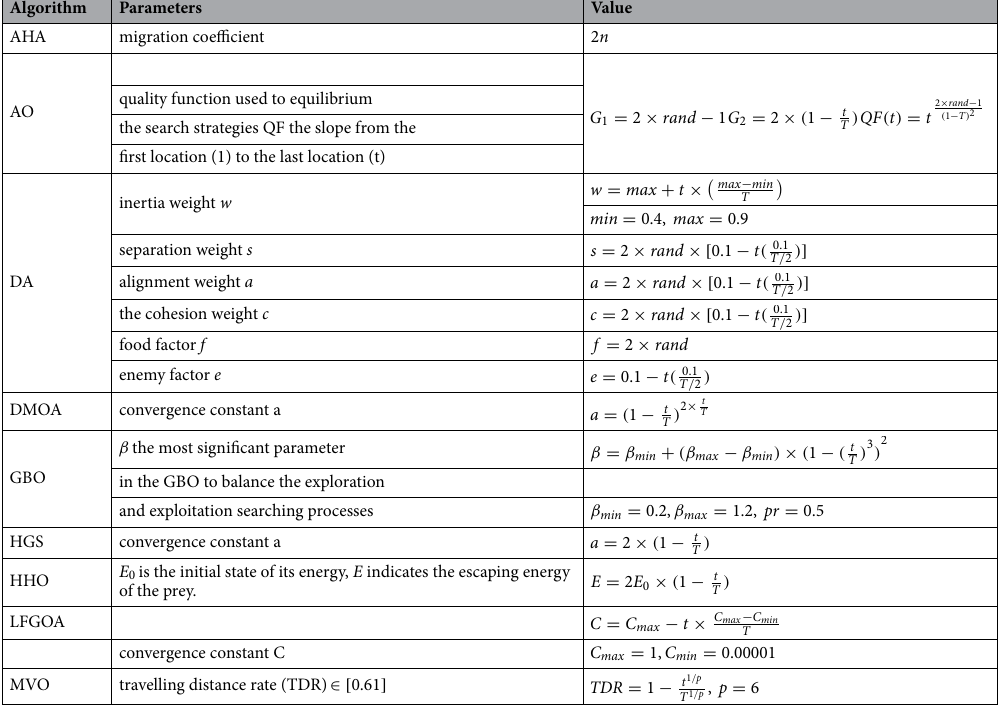
Table 2. The setup of the parameters. t Current iteration, T The maximal